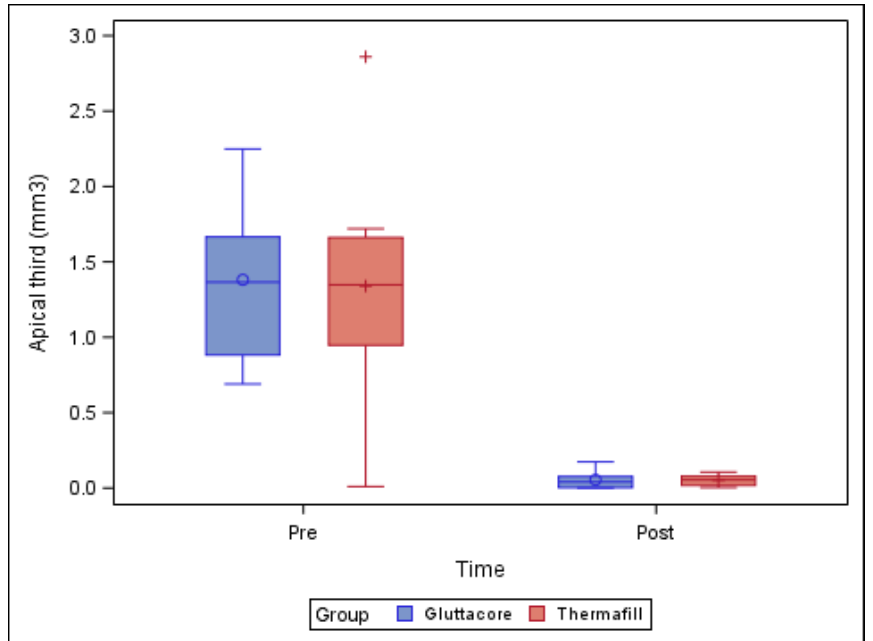
Figure 4. Box plot of the pre-operative root canal filling material volume (mm 3 ) and the remaining post-operative root canal filling material volume (mm 3 ) at the apical third of the straight root canal systems, categorized by root canal filling material system.